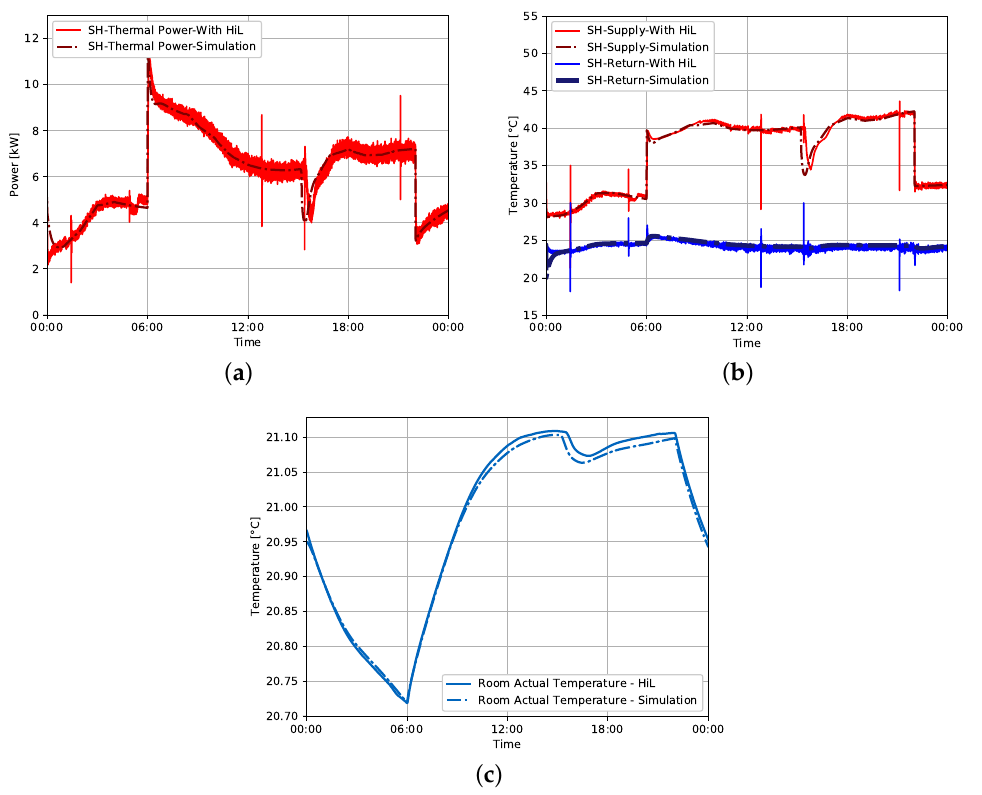
Figure 8. Comparison between the heat pump dynamics of the testbed operation with HiL and simulation model, ( a ) space heating thermal power; ( b ) space heating supply and return temperatures; ( c ) room temperature.